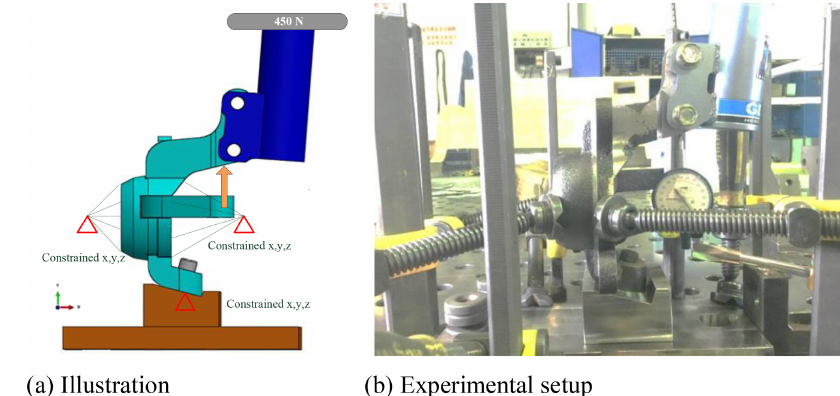
Figure 13. Knuckle arm deformation measurement under applied load of 450N.